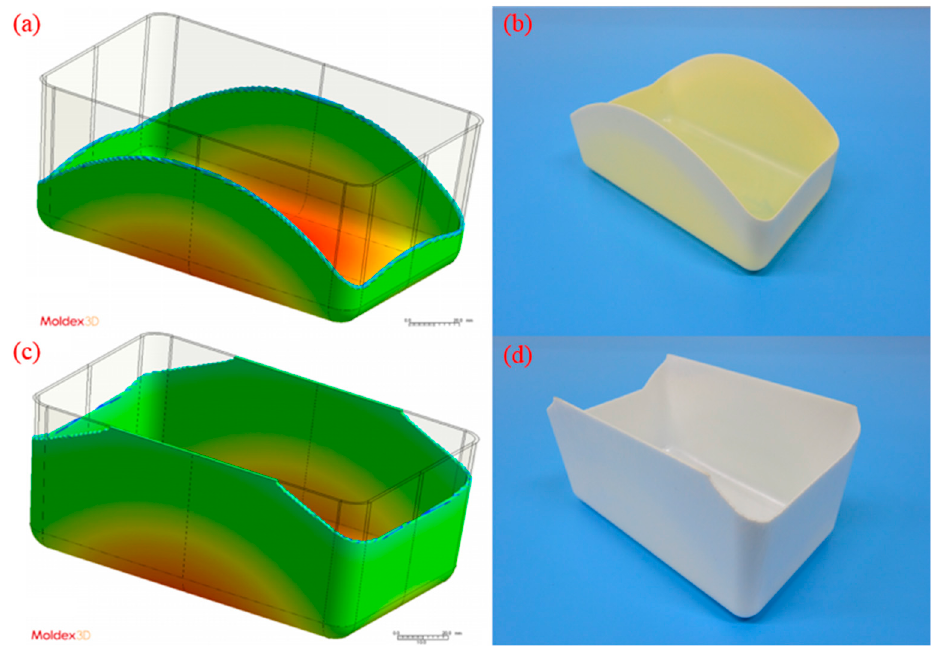
Figure 4. Simulated and experimental results using medium-level process parameters (i.e., 100 cm 3 /s injection speed, 210 °C melt temperature, and 60 °C mold temperature): ( a ) simulated result for the PP sample, ( b ) actual experimental result for the PP sample, ( c ) simulated result for the PS sample, ( d ) actual experimental result for the PS sample.